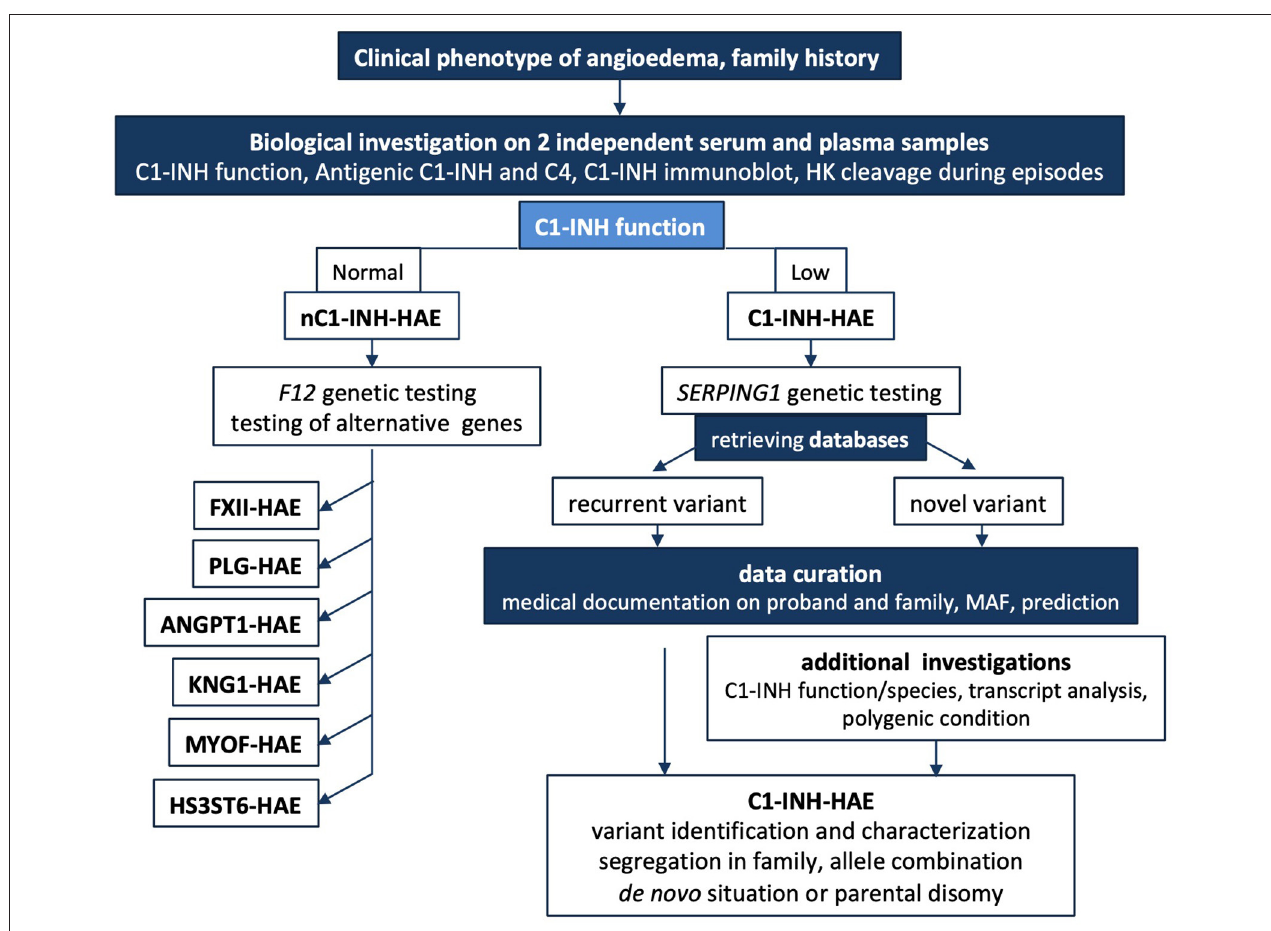
FIGURE 6 | Short algorithm for C1-INH-HAE. The medical algorithm of Caballero et al. (108) is supplemented for biological and genetic additional testings. In cases where there is a family history of HAE or the clinical history is highly suggestive of HAE, biological investigation should begin with an assessment of the established C1-INH function after 2 independent determinations on plasma; this mandatory testing can be completed by C1-INH molecular species and in some instances by high molecular weight kininogen cleavage to establish the involvement of KKS. A low antigenic C4 in serum could contribute to biological diagnostic, but false positives should be considered because C4A and C4B null alleles are common. A normal C1-INH function could suggest a nC1-INH-HAE and F12 genetic study should be performed. When unsuccessful, alternative genetic testing could be developed. SERPING1 genetic testing can confirm a C1INH-HAE diagnosis. Medical geneticists investigate a possible de novo mutation or a parental disomy on additional DNA analyses. In case of intronic variant detection, transcript distribution is investigated for noncanonical sequences. Data curation is mandatory for every novel variant submitted to sequence interpretation according to ACMG guidelines ( 57, 58). C1-INH-HAE, hereditary angioedema with C1-INH deficiency; nC1-INH-HAE, hereditary angioedema with a normal C1-INH function; F12-HAE, with gain-of-function of FXII; PLG-HAE, with gain-of-function of plasminogen; ANGPT1-HAE, with altered angiopoietin-1; KNG1-HAE, with high molecular weight kininogen susceptible to cleavage; HS3ST6-HAE, with altered heparan sulfate-glucosamine 3- O -sulfotransferase 6; MYOF-HAE, with altered myoferlin; HK, high molecular weight kininogen; MAF, minor allele